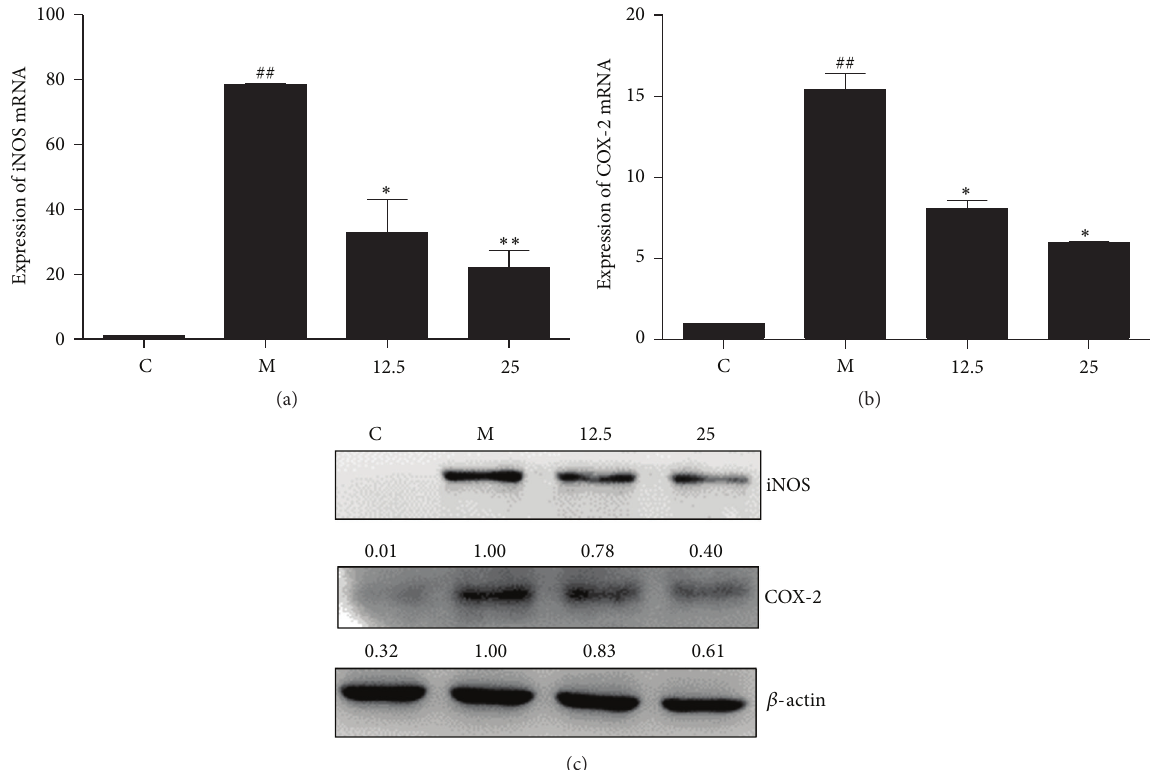
Figure 3: Effect of TIE on iNOS and COX-2 expression in LPS/IFN 𝛾 -stimulated RAW264.7 cells. (a, b) RAW264.7 cells were plated at a density of 1 × 10 6 cells in 30 mm dish overnight and treated with varying concentrations of TIE with treatment of LPS (100ng/mL) and IFN 𝛾 (10U/mL) for 4 h. Total RNA was isolated and subjected to qRT-PCR. 𝛽 -actin mRNA was used as an internal control for standardization. (c) RAW264.7 cells were plated at a density of 1 × 10 6 cells in 30 mm dish overnight. TIE was added with the treatment of IFN 𝛾 (10U/mL) plus LPS (100ng/mL) for 6 h. Whole cell lysates were prepared and subjected to Western blotting. 𝛽 -actin protein was used as an internal control for standardization. The data shown are representative of three independent experiments. ## 𝑃 < 0.01 , # 𝑃 < 0.05 versus control group; ∗∗ 𝑃 < 0.01 , ∗ 𝑃 < 0.05 versus model